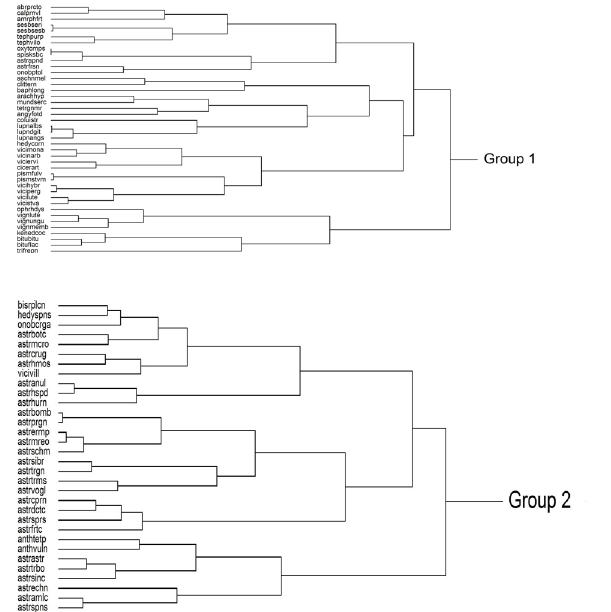
Fig. 1. Dendrogram based on the 81 characters listed in Tab. 1, recorded comparatively for 226 species of the Leguminosae- Papilionoideae, and analyzed by the Sørensen distance measure and Ward`s clustering method. The % chaining is